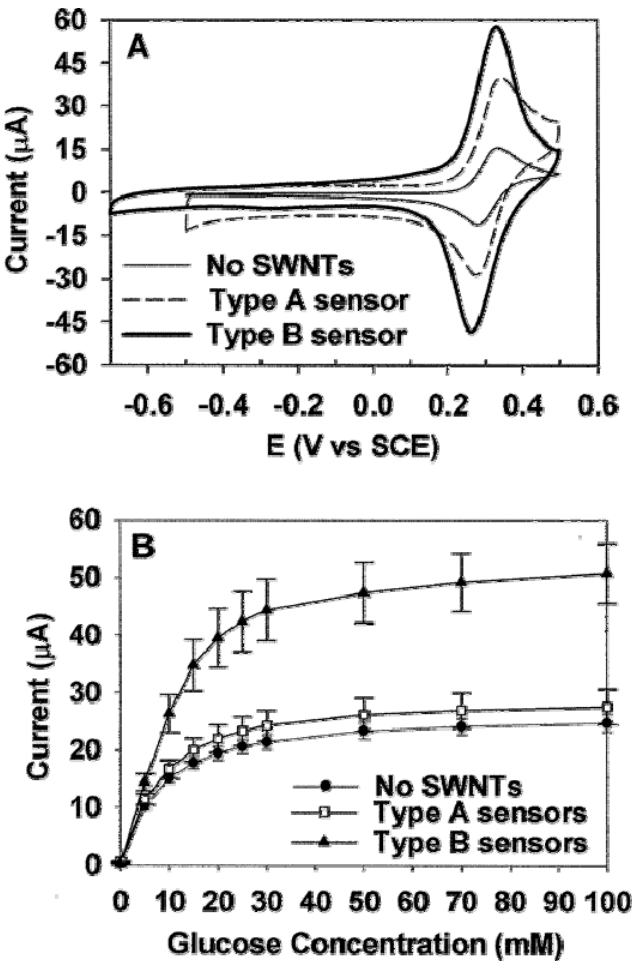
Figure 5. Electrochemical characterization of glucose oxidase sensors. (A) Cyclic voltammograms of a GCE modified with the redox hydrogel alone (-); a GCE modified first with a film of SWNT and then coated with the redox hydrogel (----) ( type A sensor); (III) a GCE modified with a redox hydrogel containing GOX-treated SWNTs (-) (type B sensor). Scan rate 50 mV/s. (B) Glucose calibration curves for the three types of sensors described in (A). T = 25C, E = 0.5 V vs SCE. Values are mean  SEM